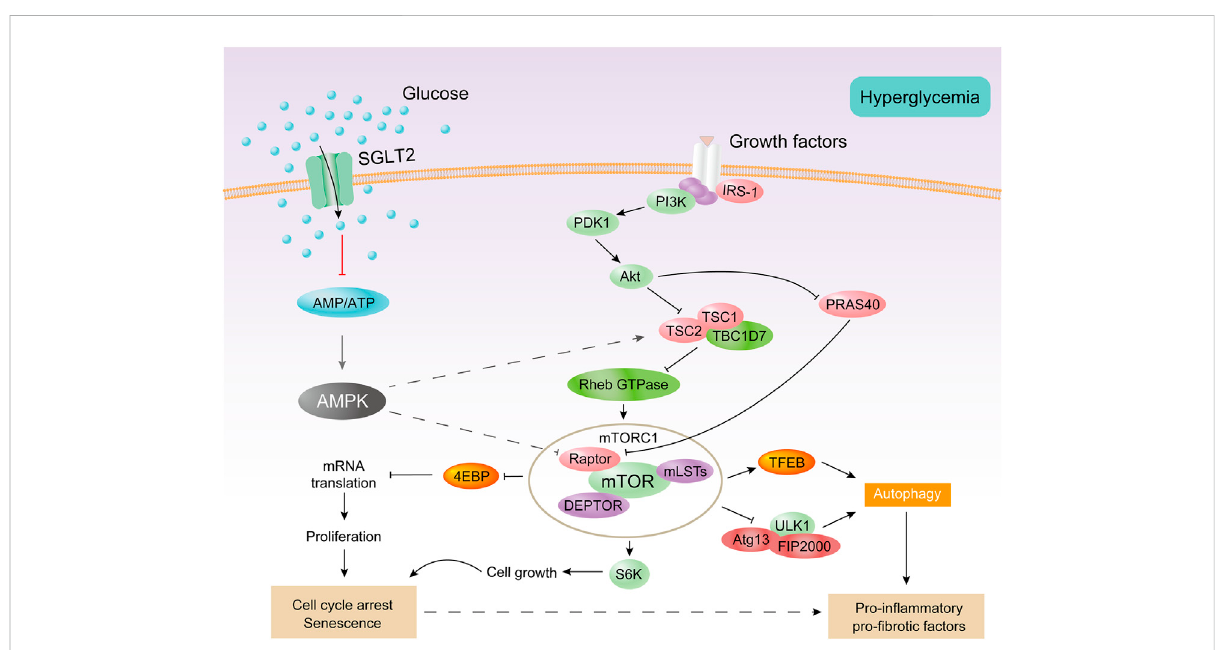
FIGURE 4 AMPKandmTORC1areinvolvedintheproximaltubularcellresponsetodiabetes.Underdiabeticconditions,excessiveenergysubstratesinhibit AMPK. Filtering and locally producing growth factors as well as hyperglycemia can activate mTORC1. Activation of mTORC1 impairs autophagy and promotes cell proliferation, followed by cell cycle arrest and hypertrophy, thereby producing senescent-like cell phenotypes. All of these processes are associated with in fl ammation and fi